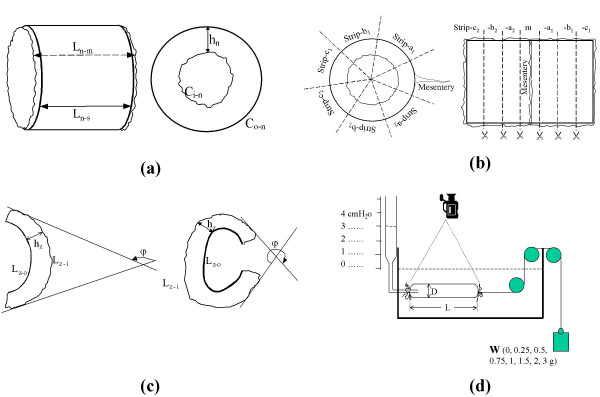
A No-load state. Left: Image of intestinal segments. Mucosal length (Lm), serosal length (Ls). n denotes the no-load state. Right: cross sectional image. Wall thickness (h), circumference (C), inner (mucosal) surface (i), and outer (serosal) surface (o). B Illustration of the way of cutting the tissue and labelling of the strips. Intestinal segments were cut into longitudinal strips and labelled according to their circumferential locations. Strip-m (strip at the mesenteric side), strip-a1 and strip-a2 (strips near the mesenteric side), strip-b1 and strip-b2 (strips near the anti-mesenteric side), strip-c1 and strip-c2 (strips at the anti-mesenteric side). C Longitudinal zero-stress state. Longitudinal strips tend to bend towards serosa. The zero-stress state is denoted by z, and the bending angle by φ D Longitudinal stress-strain experiment in rat small intestine. The illustration of the distension experimental set up on ileal segment. At each pressure of 0, 1, 2, 3 and 4 cmH2O, put weight of 0, 0.25, 05, 0.75, 1, 1.5, 2, and 3 gram on the distal end respectively. Three minutes were awaited to acquire equilibration after applying a combined intraluminal pressure and pulling force. D, L and W denote diameter, length and weight, respectively.